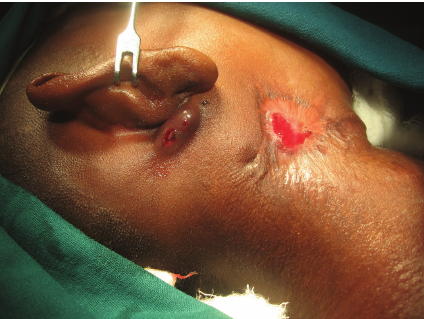
Figure 1: Clinical photograph showing inflammatory opening in right side of neck and a swelling behind the ear.